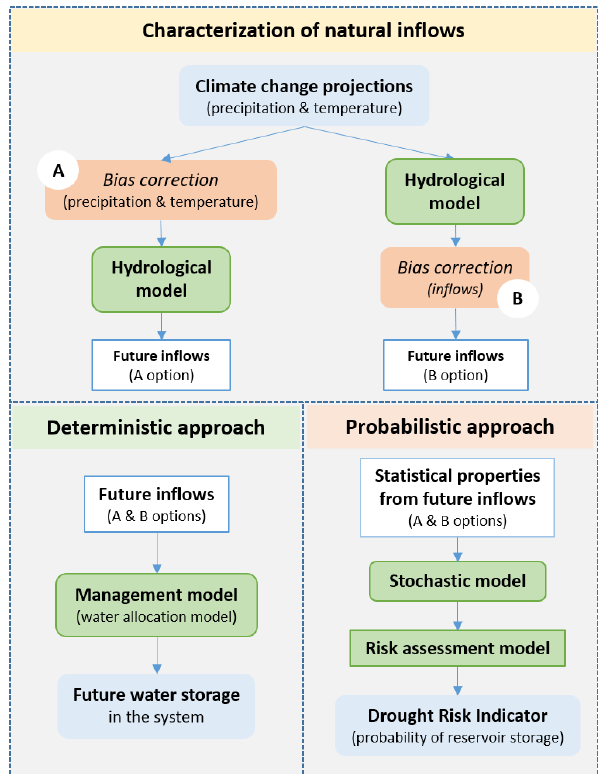
Figure 2. Methodology for the integration of climate change projec- tions into the management and risk assessments to support decision-